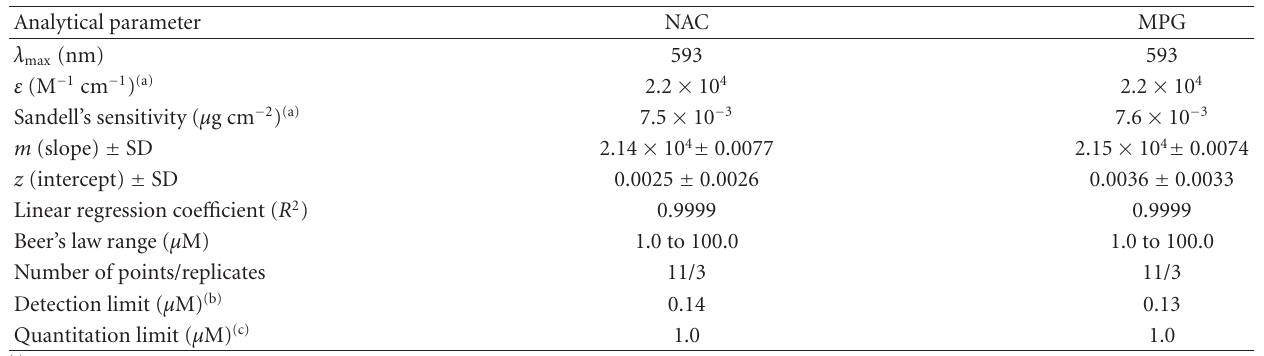
Table 1: Spectral characteristics and analytical parameters of the method for NAC and MPG under optimum reaction conditions.